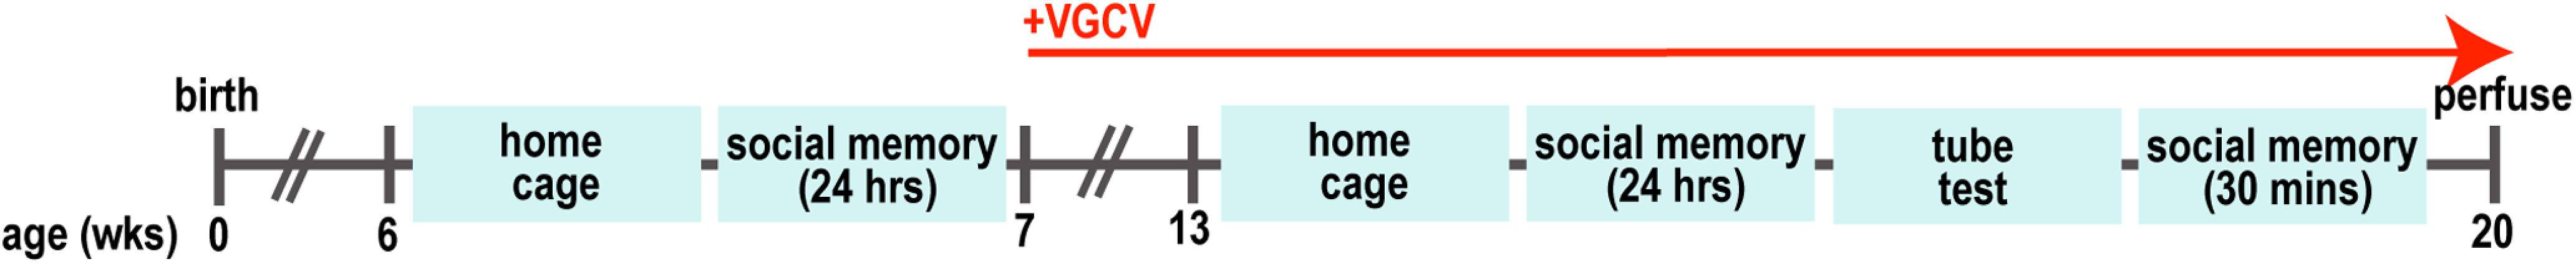
 Experimental timeline. Six-week-old CD1 and GFAP-TK mice were examined for home cage behavior and social memory with a 24 h delay in between trials. After behavioral testing, CD1 and GFAP-TK mice were treated with VGCV in powdered chow for six weeks. Mice were then reexamined for home cage behavior and social memory with a 24 h delay in between trials at ∼13 weeks of age. Mice then underwent social hierarchy testing using the tube test at ∼17 weeks of age and then retested for social memory with a 30 min delay in between trials at ∼19 weeks of age. Mice were perfused at the end of the study.